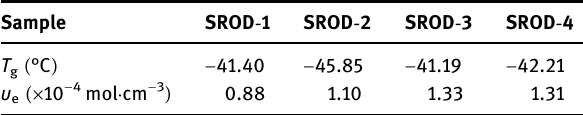
Table 4: Thermomechanical properties of RTV silicone rubber